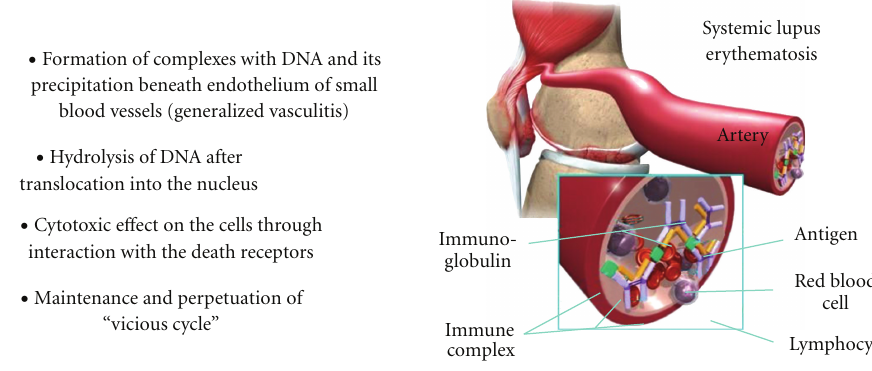
Figure 2: Lupus anti-DNA antibodies and their importance in SLE